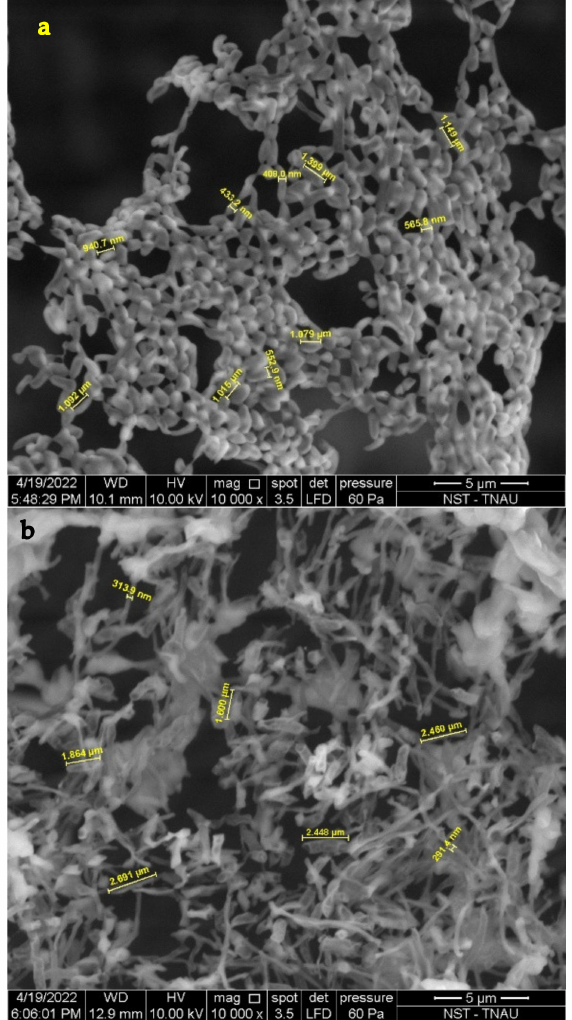
Figure 9. Franconibacter helveticus L2C1L2 under ( a ) unstressed and ( b ) stressed